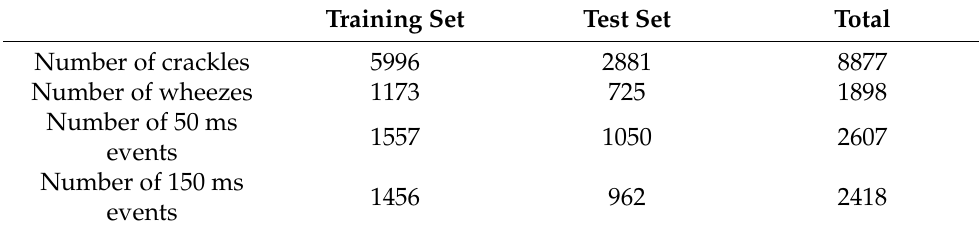
Table 3. Number of randomly generated events (RGE) with fixed durations in the training and test sets.